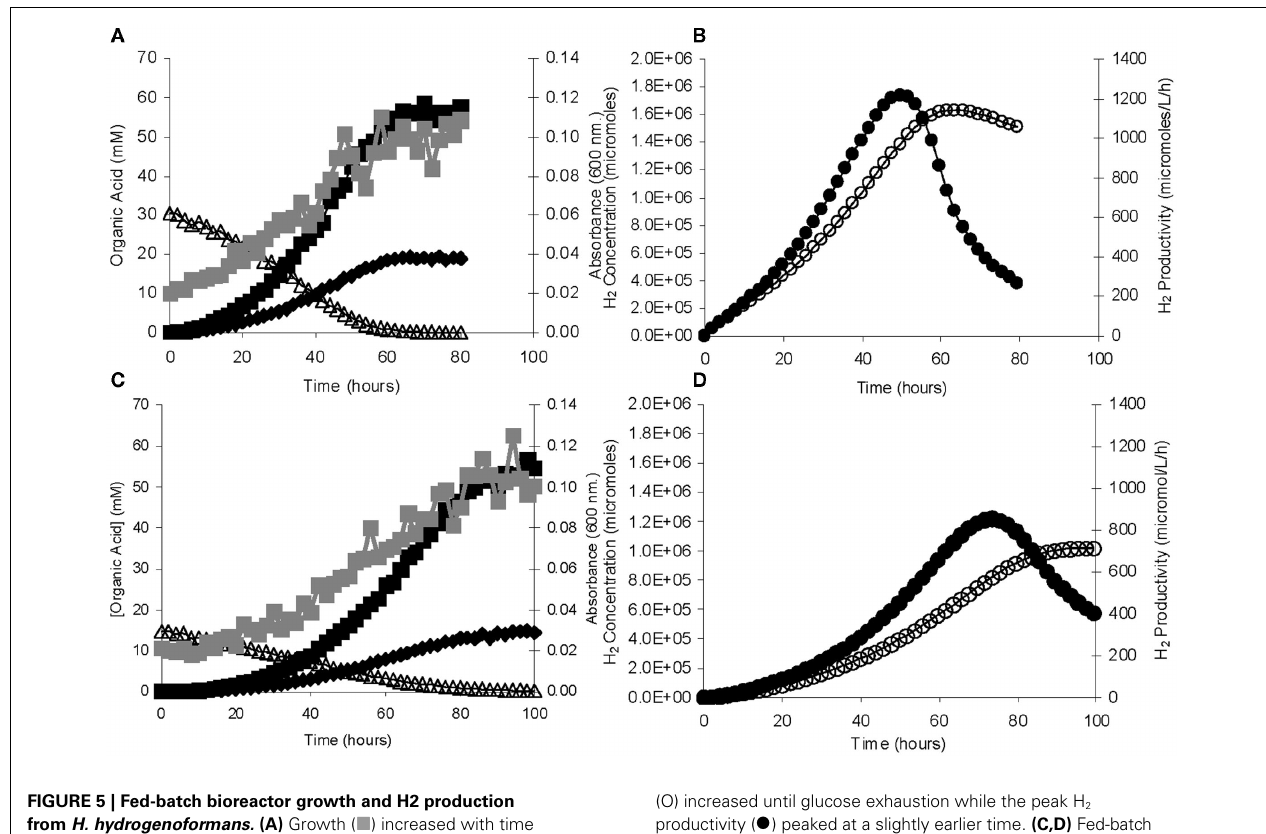
(O) increased until glucose exhaustion while the peak H 2 • productivity ( ) peaked at a slightly earlier time. (C,D) Fed-batch bioreactor growth and H 2 production with 15mM cellobiose using the same symbols.